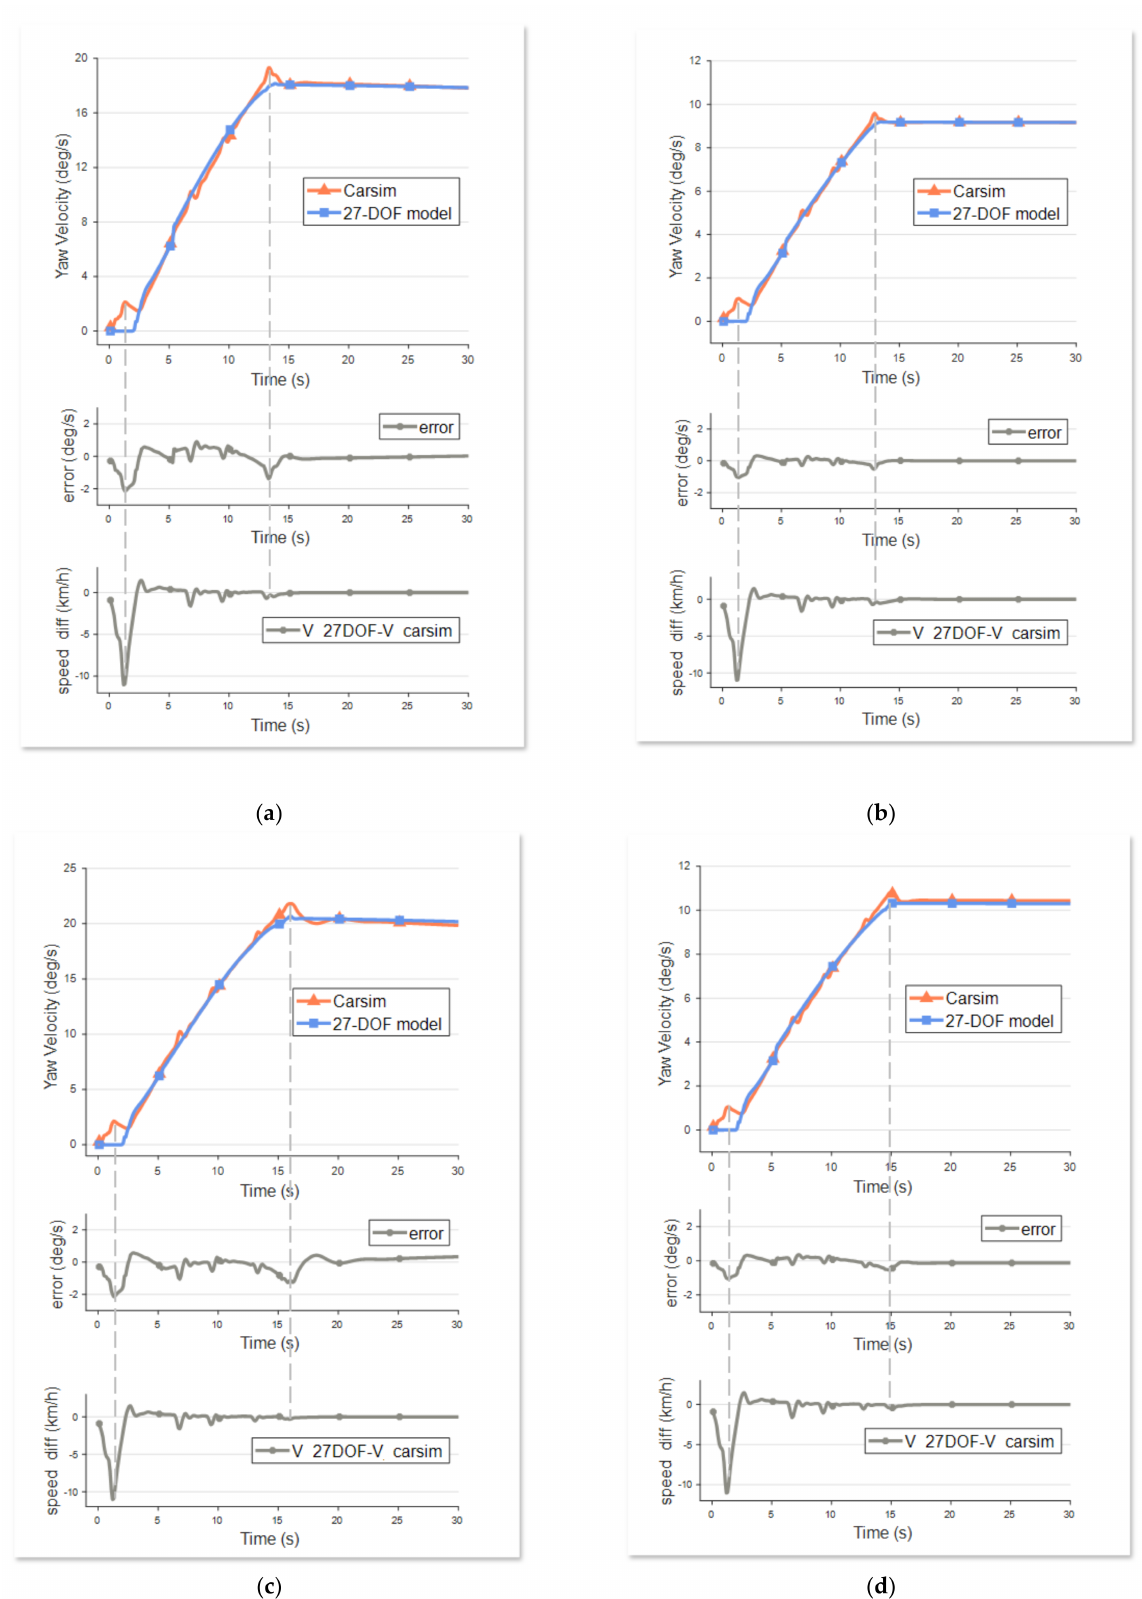
Figure 6. Yaw velocity of the 27-DOF model and CarSim in different scenarios. ( a ) speed = 55 km/h; radius = 50 m. ( b ) speed = 65 km/h; radius = 50 m. ( c ) speed = 55 km/h; radius = 100 m. ( d ) speed = 65 km/h; radius = 100